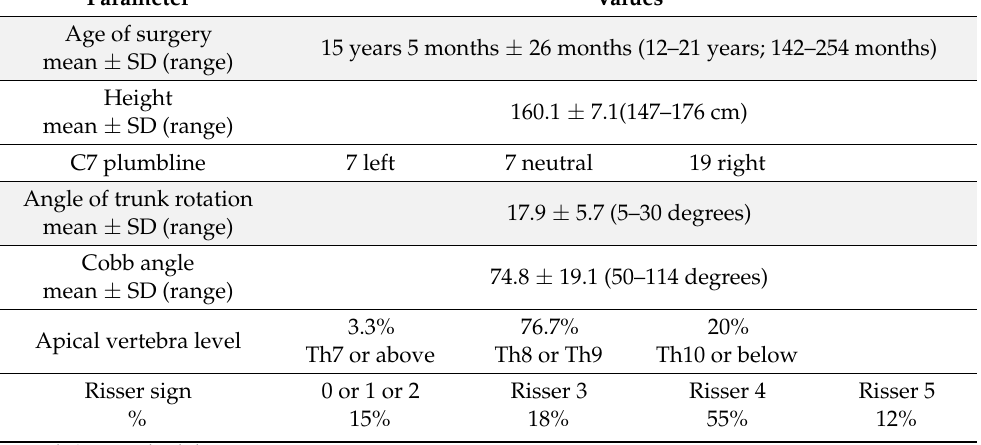
Table 1. Selected parameters measured in the